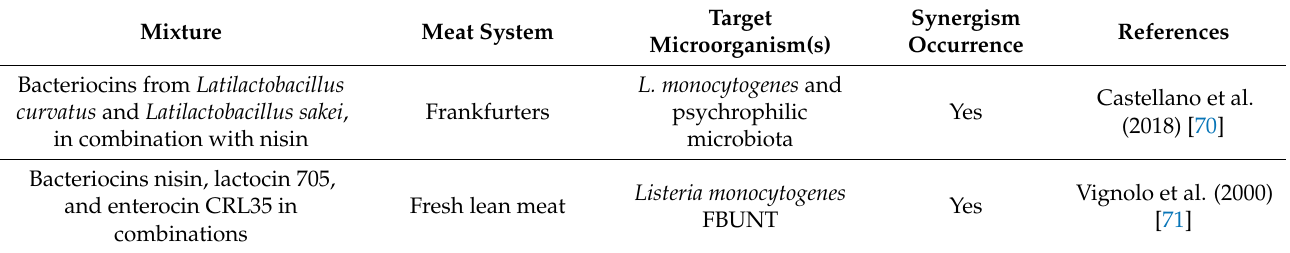
Table 3. The use of diverse combinations of bacteriocins against different target